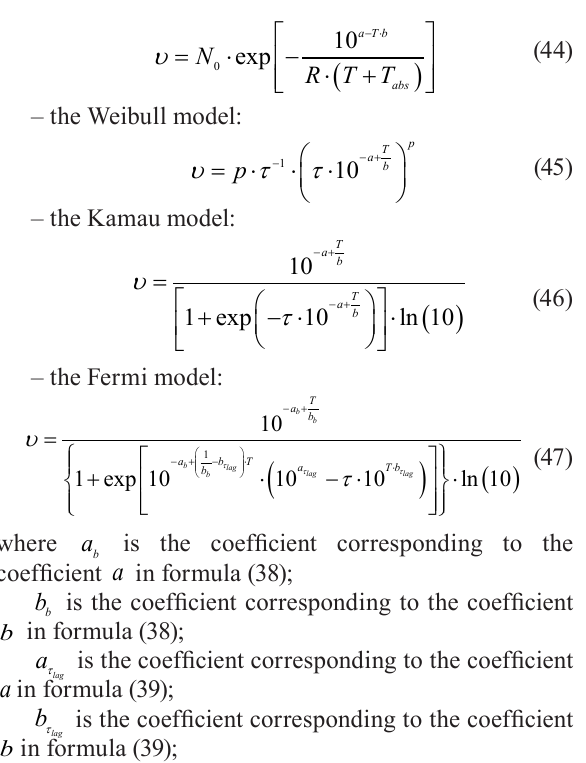
Figure 8 Secondary nonlinear models of microbial death of A. acidoterrestris during heat treatment (a) Membre model, (b) Augustin